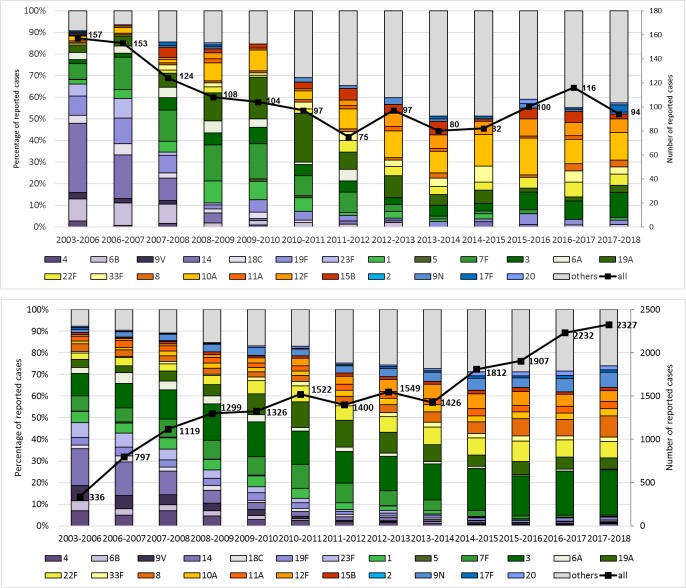
Coverage of current and future vaccine formulations among children <2 years (top) and among adults 60 years and older (bottom) with IPD in Germany.PCV7 (purple), PCV13non7 (green), PCV15non13 (yellow) and PCV20non15 (orange). PPV23 serotypes not in PCV20 (blue), Serotype 6A (white). Exact values for individual serotypes are included in S2 Table. Data for 2003–2006 are composite numbers of the three epidemiological years, divided by three.